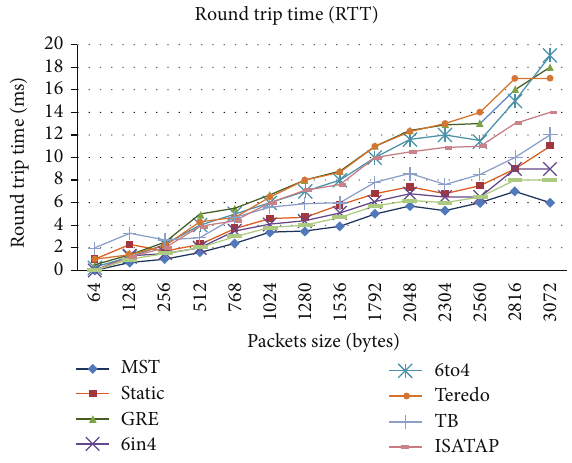
Figure 7: Latency analysis.